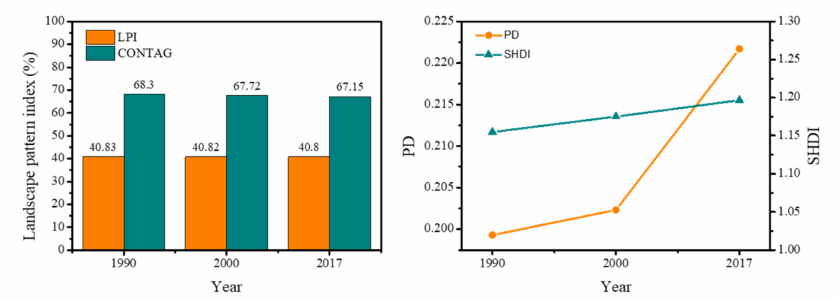
Figure 4. Changes in landscape index in the PRD region from 1990 to 2017.